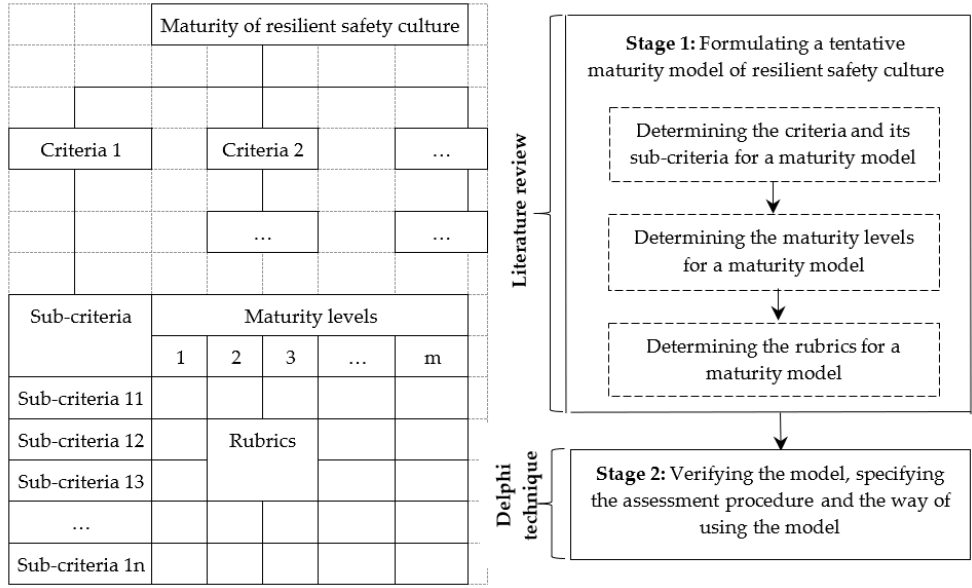
Figure 1. Structure of the maturity model of resilient safety culture and research process.